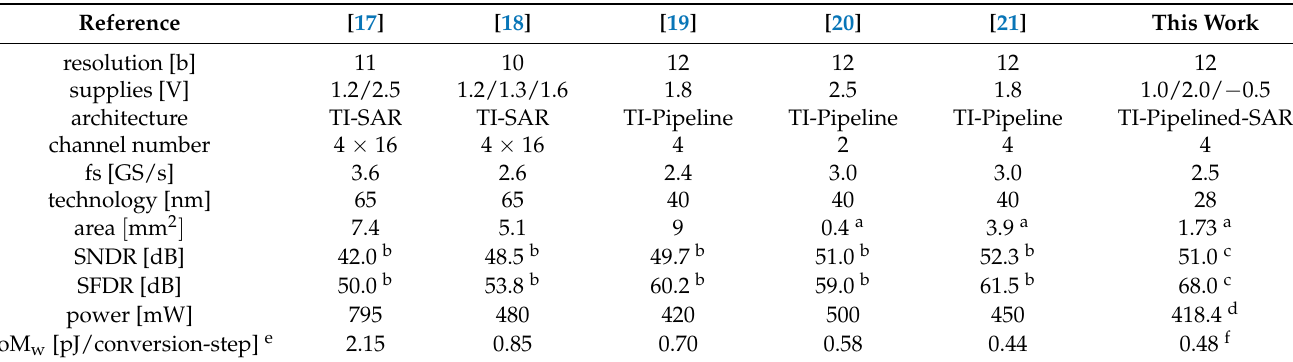
Table 1. Performance Summary and